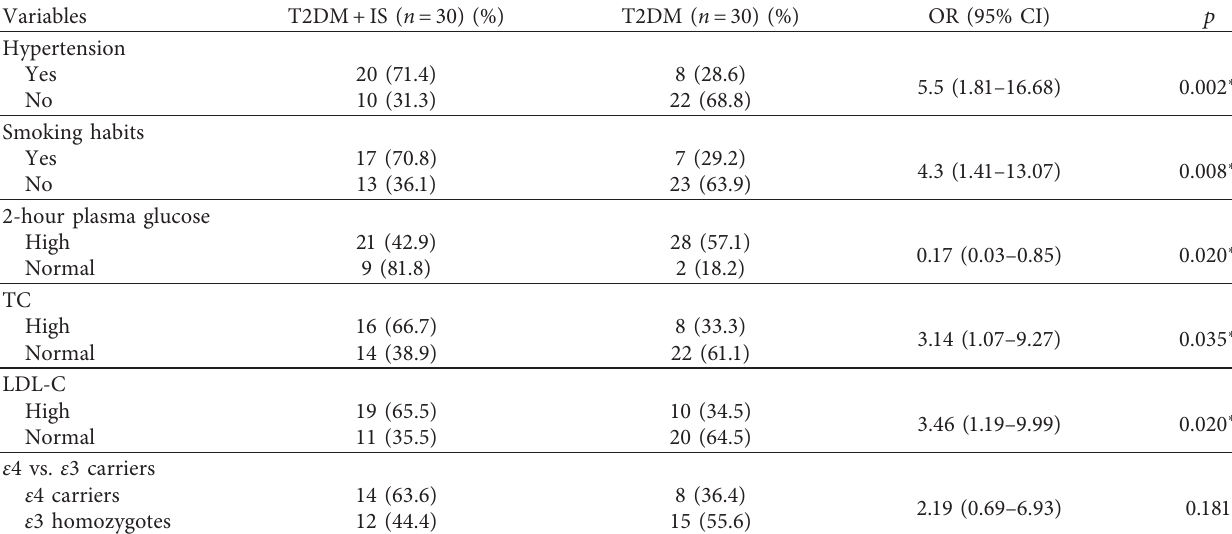
Table 4: Bivariate analysis of variables related to ischemic stroke in T2DM.